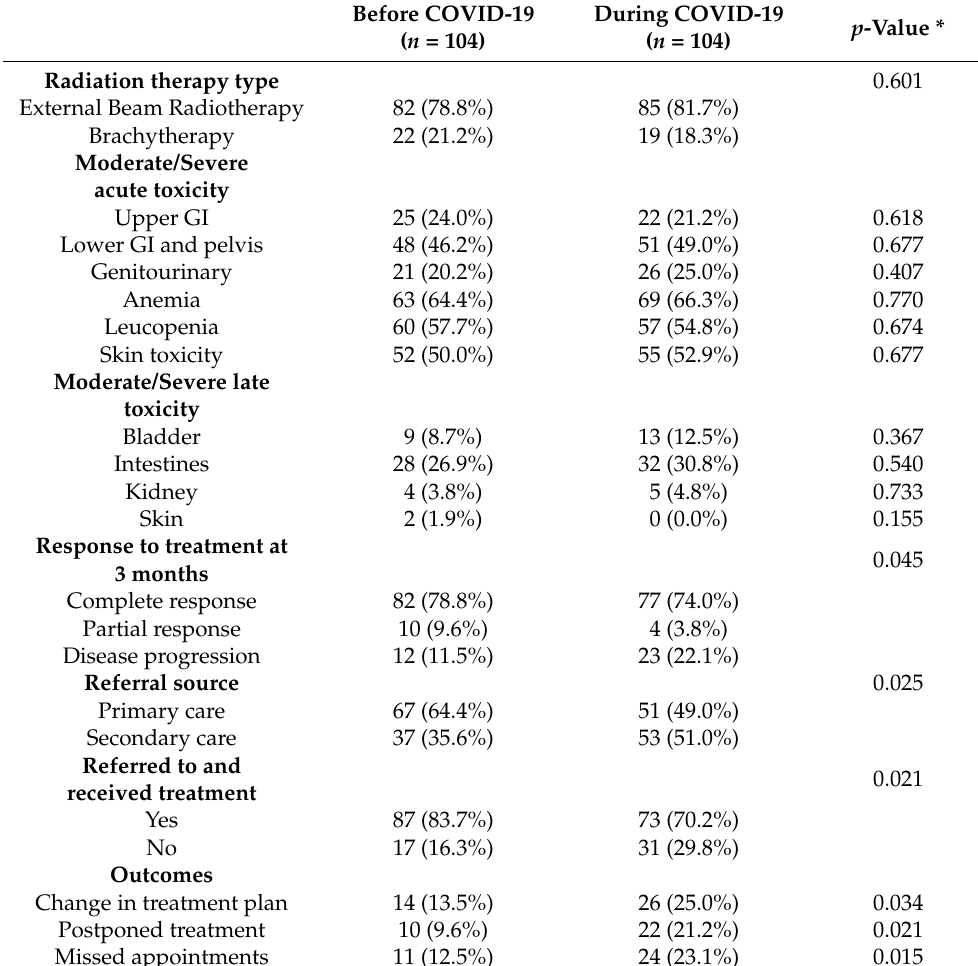
Table 3. Radiotherapy characteristics of women with cervical cancer before and during the COVID-19 pandemic.